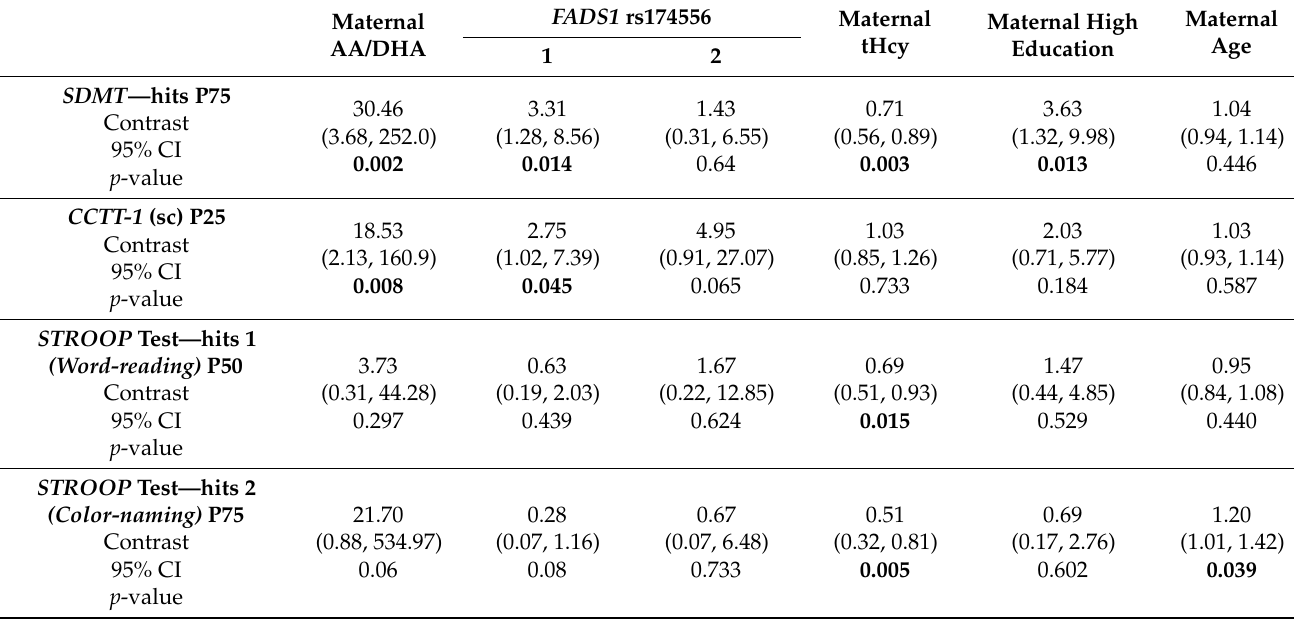
Table 4. Logistic regression analysis after dichotomizing children aged 9 years of age below or above P75, P50 or P25 for Symbol Digit Modalities Test ( SDMT ), Children Color Trails Test (CCTT-1) and STROOP Test. Only significant associations are